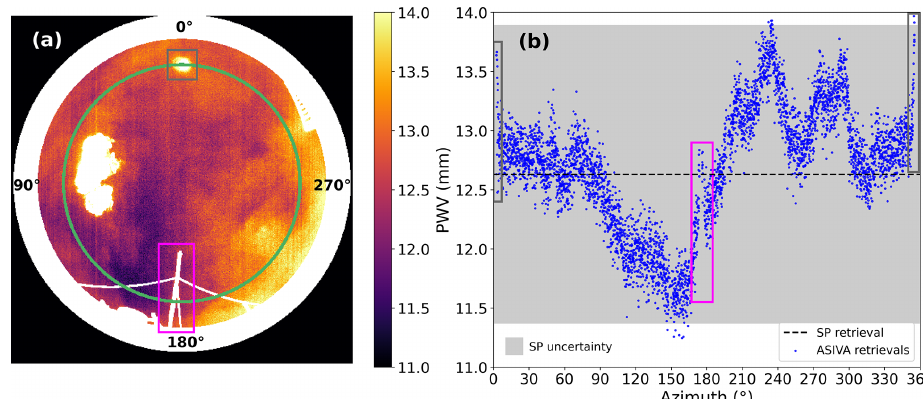
Figure 9. ( a ) PWV sky mapping corresponding to Fig. 1 measurements on 6 July 2017 at 15:17UTC (12:17LT). Masked-out pixels are shown in white. The green line indicates an air mass of 1.45 ± 0.02. The solar disk and a nearby structure are highlighted as gray and magenta rectangles, respectively; ( b ) PWV vs. true north azimuth along the green line in (a) . The temporally matched sun photometer (SP) PWV retrieval is shown as a horizontal dashed line. The shaded area corresponds to the SP uncertainty. Gray and magenta rectangles identify data gaps or ASIVA PWV retrievals influenced by the structures identified in panel (a)